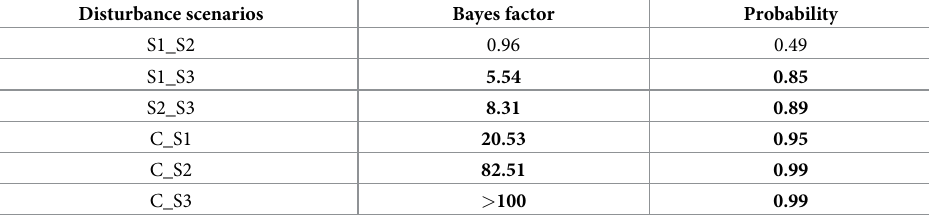
Table 5. BF for differences in nursing duration between the disturbance scenarios and control observations (in which no disturbance occurred). The probability that the nursing duration in the first scenario was longer than in the second one is also shown. Scenario 1 (S1)–although nursing is momentarily interrupted by a disturbance, the mother- pup pair does not flush and continues to nurse; Scenario 2 (S2)–nursing is interrupted by a disturbance and the pair flushes, but recovers in less than 10 min and continues to nurse; and, Scenario 3 (S3)–nursing is interrupted by a dis- turbance, the pair flushes, and nursing does not resume until the end of the low tide cycle occurring during the sam- pling effort conducted on that day. The control observations (C) comprised nursing events that were not interrupted because no disturbance source was present. Disturbance scenarios Bayes factor Probability